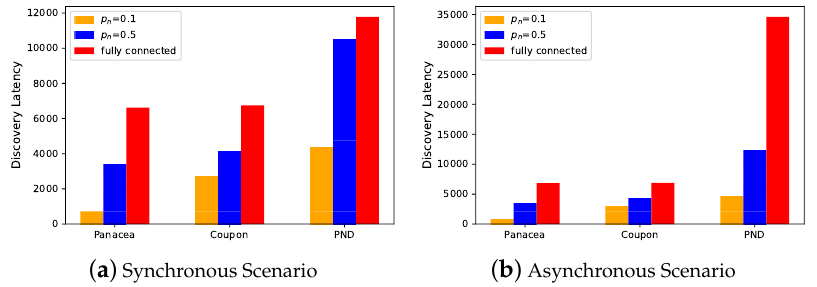
Figure 1. The neighbor discovery algorithms work better in partially connected networks and Panacea -NCD ( Panacea no collision detection) outperforms the other algorithms.